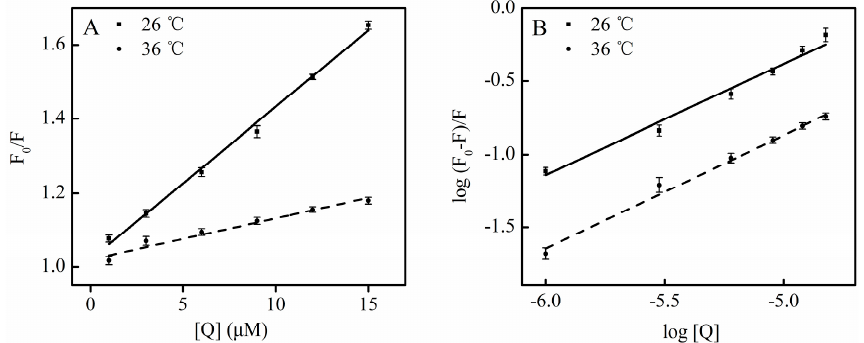
Figure 3. Plots for the interaction of SSC with HSA. Experimental conditions were as described in Figure 2. ( A ) Stern-Volmer plots for the binding of SSC to HSA; ( B ) Double-reciprocal plots for log (F 0 − F)/F vs. log [Q]; F 0 , HSA fluorescence intensities without the quencher; F, HSA fluorescence intensities with the quencher. [Q], SSC at 0, 1, 3, 6, 9, 12 and 15 μ M, respectively.